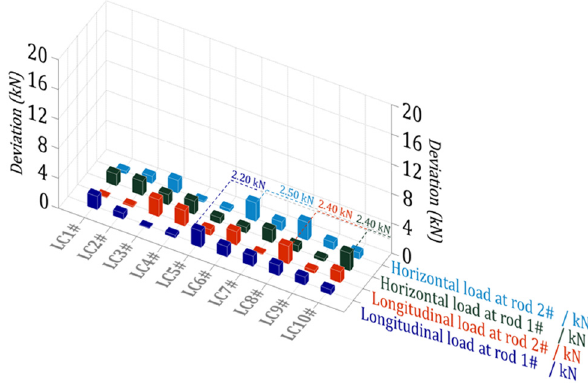
Figure 10: Deviation between identi fi ed and given load.